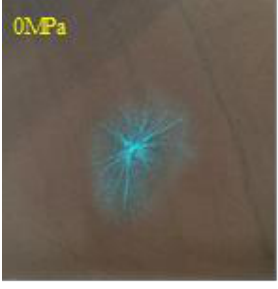
Figure 13. The crack distribution in specimen S0.